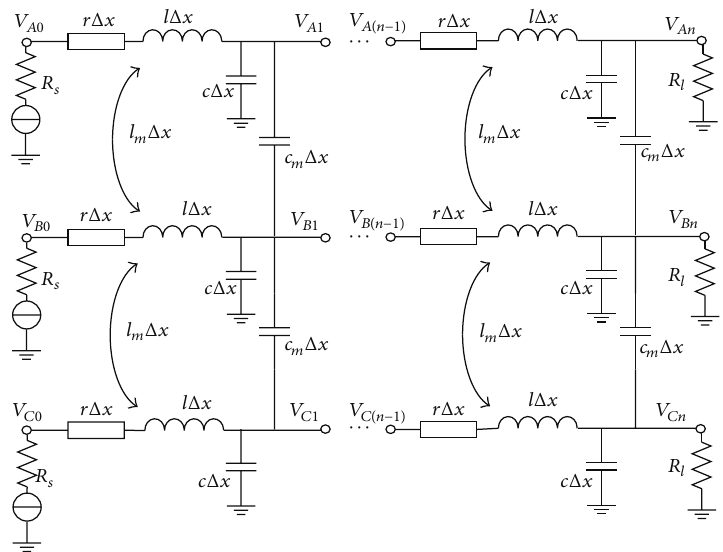
Figure 5: Driver line and victim line